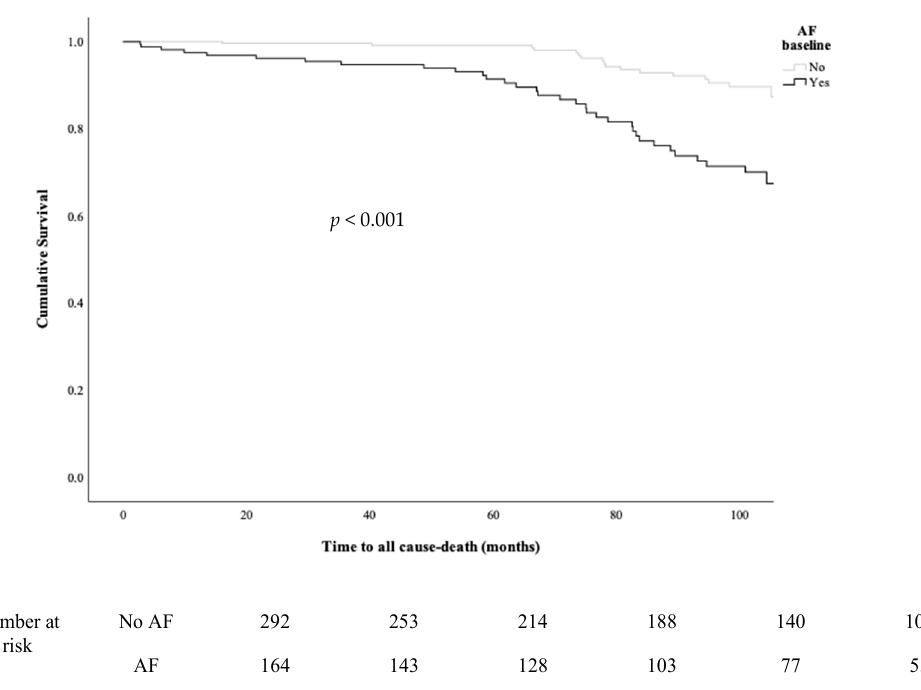
Figure 3. Kaplan–Meier curves among operated VHD patients stratified by the presence of AF for all-cause death.